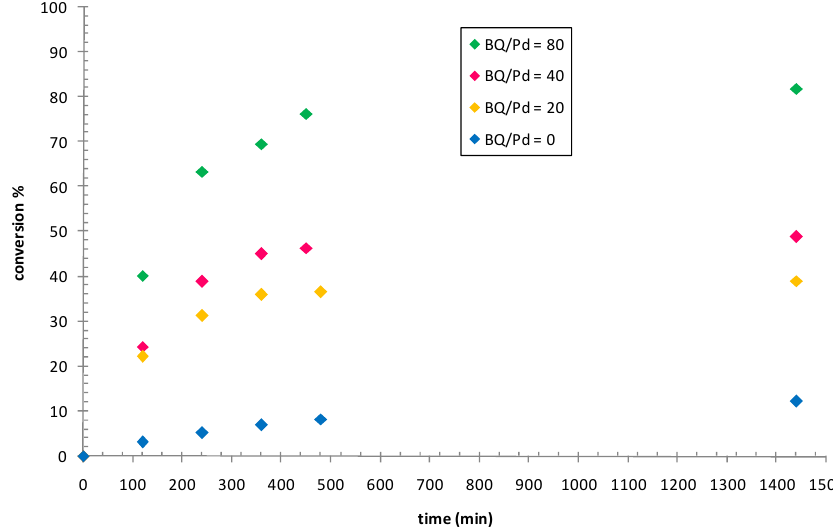
Figure 7. Styrene dimerization: effect of [BQ]/[Pd]. Precatalyst: 1b .